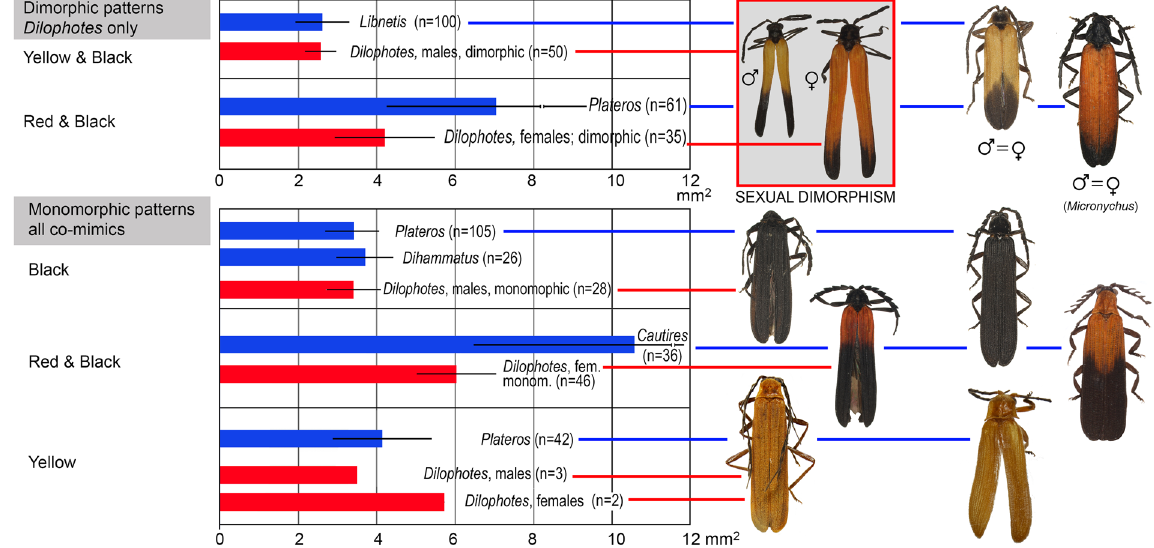
Figure 7. Average body size of Dilophotes and their co-mimics (n = number of measured individuals).